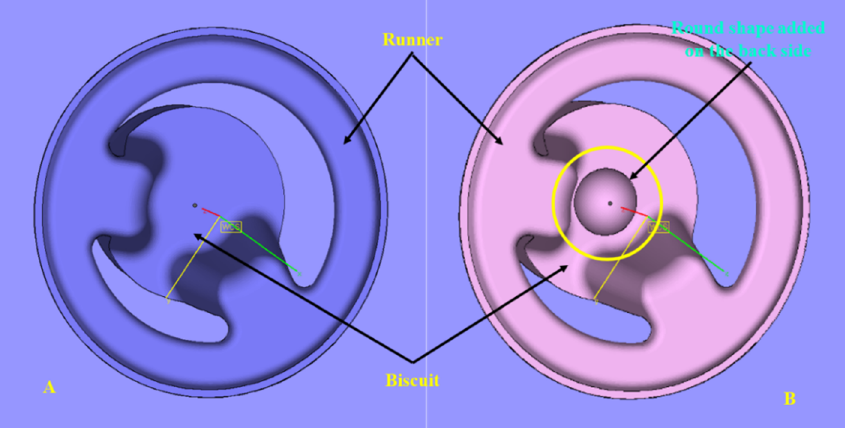
Figure 7. Gate system: ( A ) case 2; ( B ) case 3.